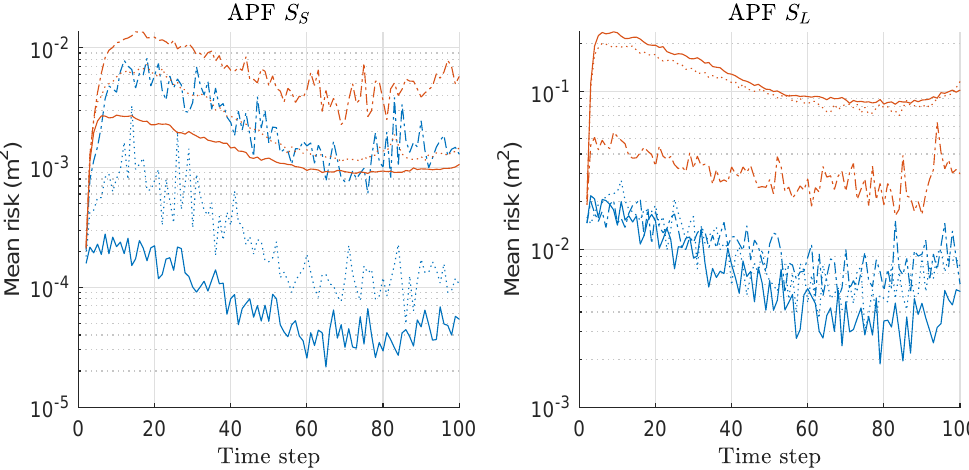
Figure 5. Mean-risk over 300 runs with 1000 particles based on Equation (20) for APF and MAPF. Results regarding only r x are shown, and those regarding r y showed similar results. Legend: line style (dash-dot: M = 2; dotted: M = 5; solid: M = 10); (line color: blue: APF; red: